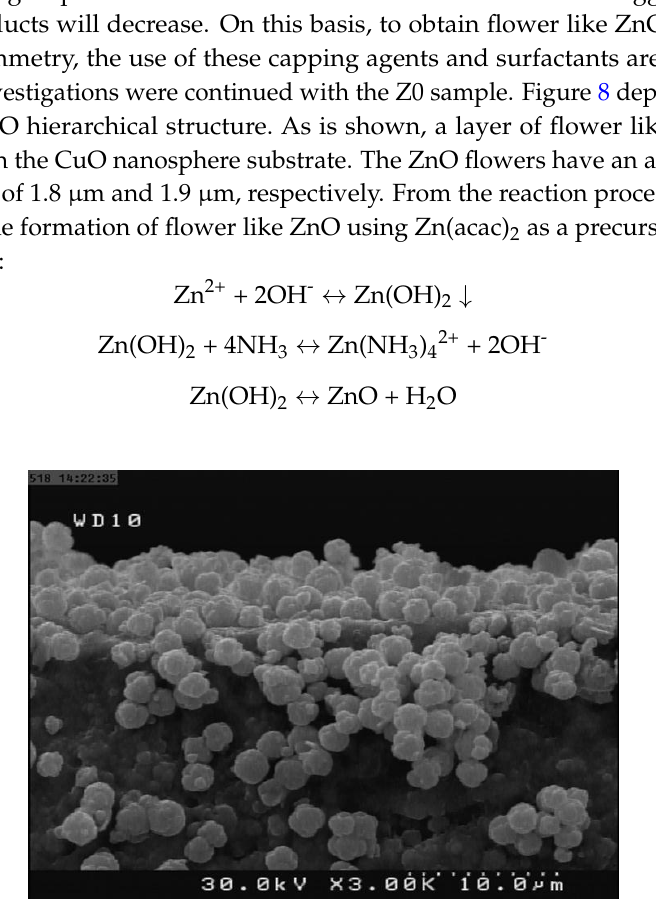
Figure 8. Cross section view of the flower-like CuO-ZnO hybrid hierarchical nanostructures prepared without any surfactant or stabilizer.